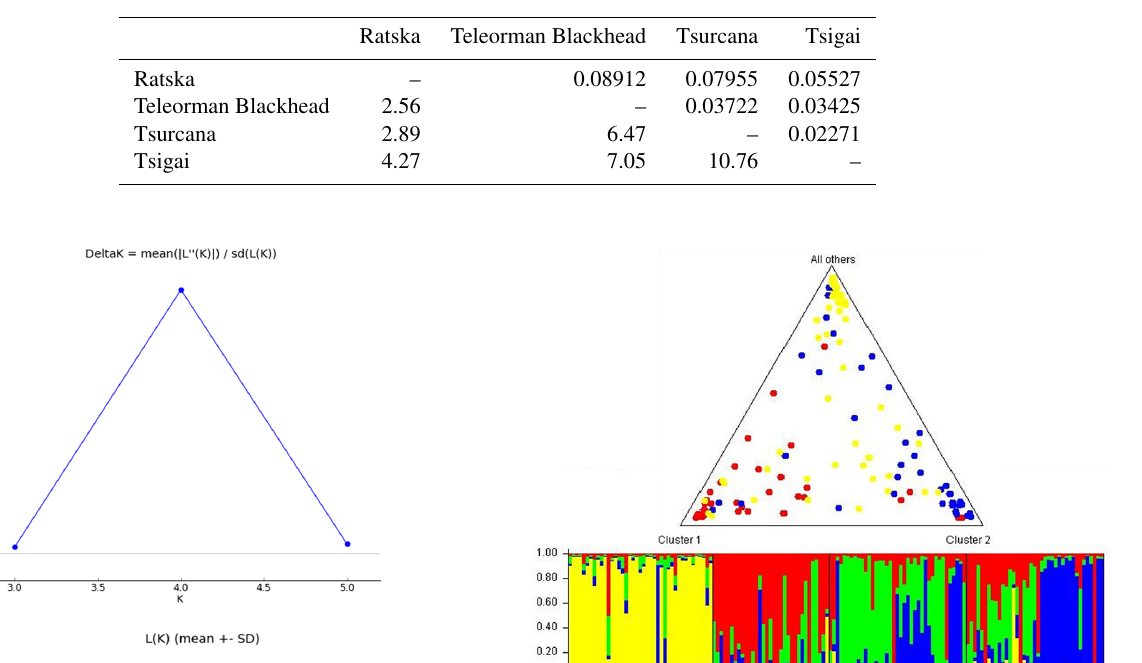
Table 3. Pairwise genetic differentiation ( F st ) (above the diagonal) and number of migrants per generation ( N m ) (below the diagonal).